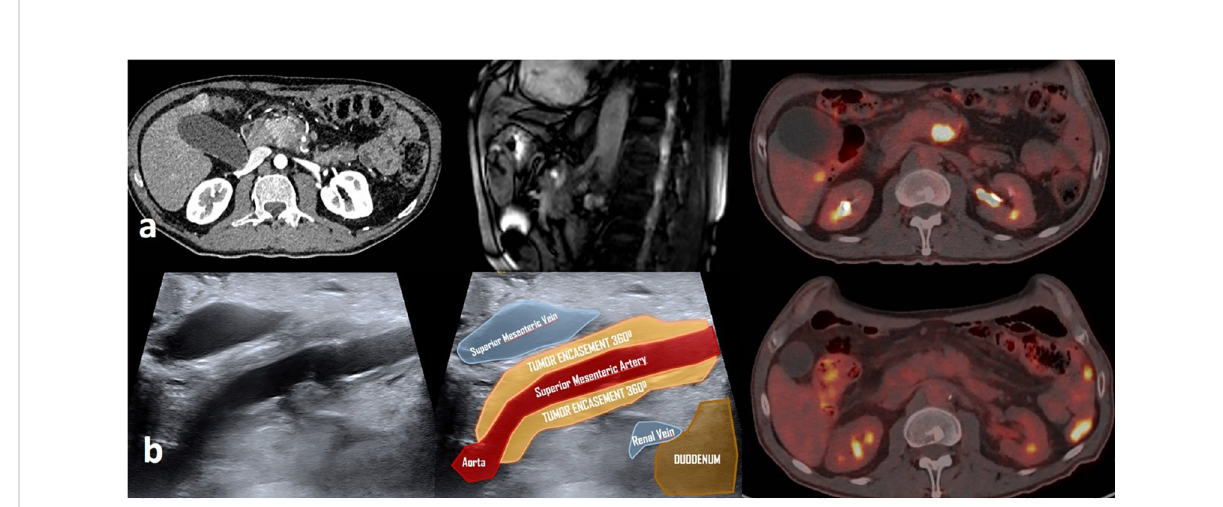
FIGURE 5 Imaging studies evolution in a patient with unresectable pancreatic cancer treated with induction chemotherapy FOLFIRINOX, neoadjuvant chemo-radiation with proton therapy and IOeRT boost consolidation. (A) Initial diagnostic studies (angioCT, MRI, and PET-CT) showing the vascular involvement and unresectable nature of the disease. (B) Post-treatment imaging studies showing a complete metabolic remission and a 360° encasement of the superior mesenteric